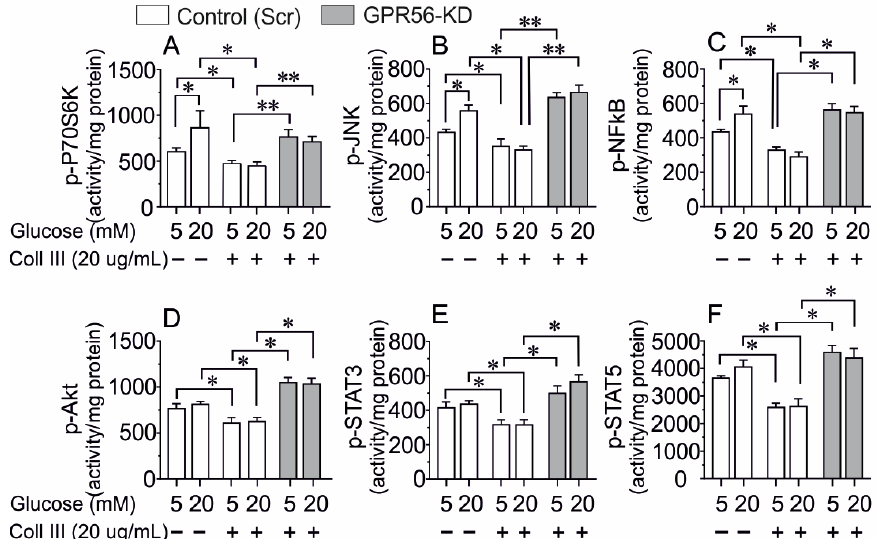
Figure 1. The Effect of Collagen type III (Col III) on the major signaling pathways in scramble control (Scr control) and Gpr56-KD INS-1 832/13 cells cultured at 5 or 20 mM glucose for 72 h. Col III suppressed the activity of P70S6K ( A ), JNK ( B ), AKT ( C ), NF κ b ( D ), STAT3 ( E ), and STAT5 ( F ) in scr control but not in GPR56-KD cells. Detection of phosphorylated P70S6K, JNK, AKT, NF κ b, STAT3, and STAT5 were assayed on the cell extracts by Luminx. The results are Mean±SEM for n = 6 − 8 different experiments in each group. * p < 0.05; ** p < 0.01.